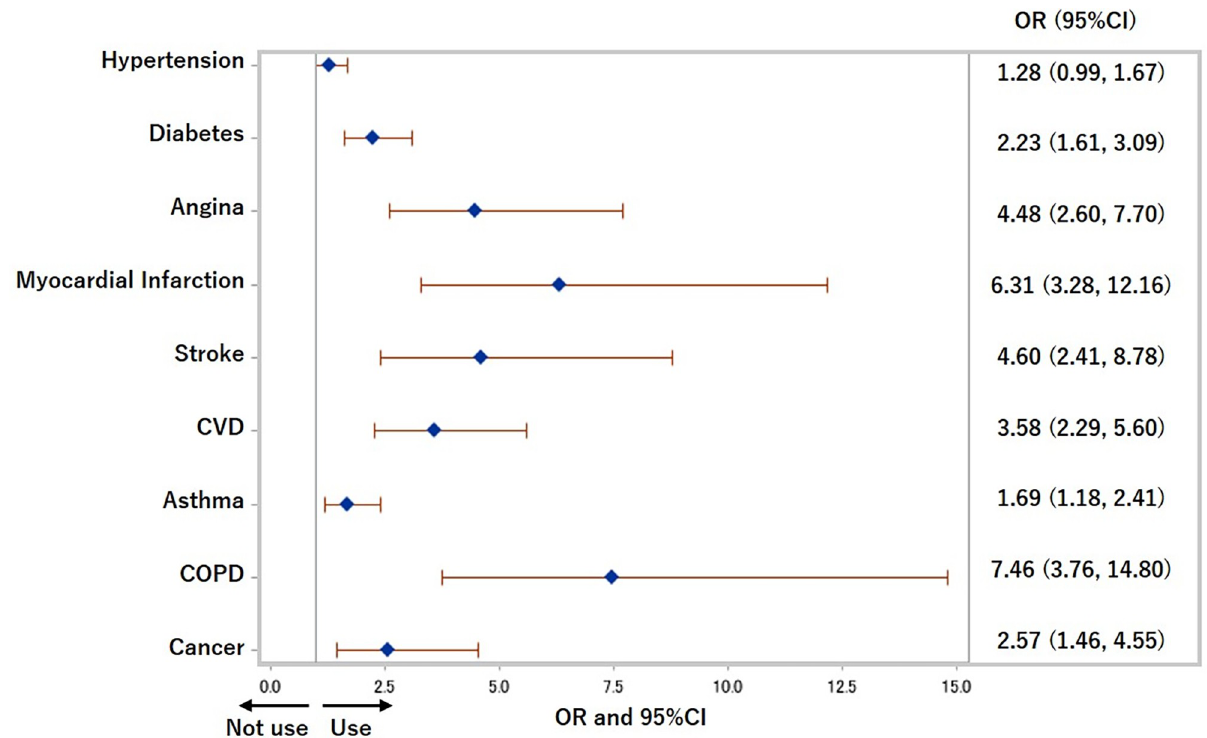
Fig 4. Odds ratios for use of both cigarettes and heated tobacco products in previous 30 days. COPD: Chronic obstructive pulmonary disease, CVD: Cardiovascular disease, OR: Odds ratio. Adjusted for age, sex, equivalent household income, education, and drinking status.